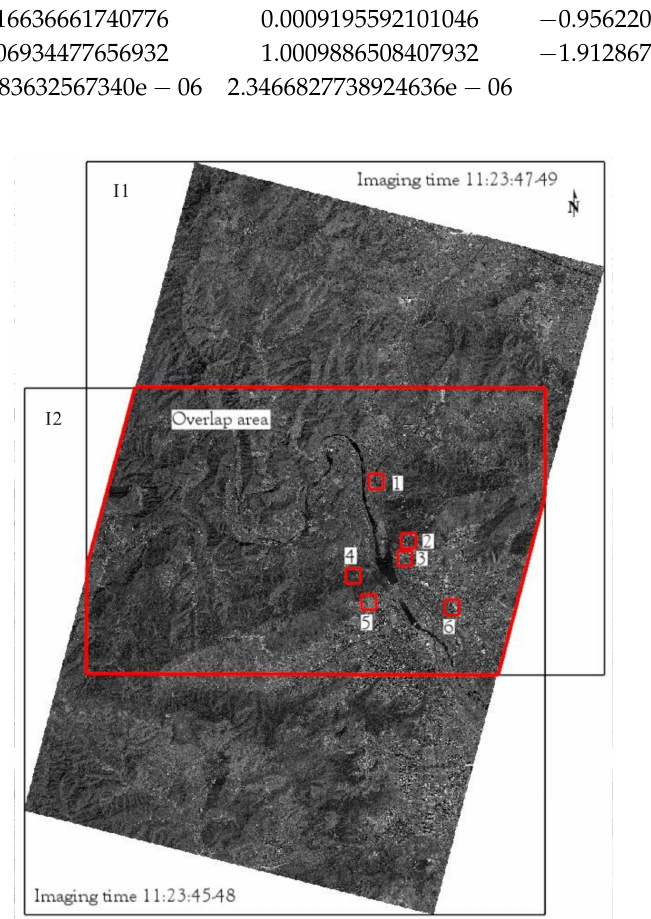
Figure 10. Test field in Mentougou district, Beijing, China. (1) expressway; (2) rural road; (3) bungalow; (4) tree; (5) bare soil; (6) high-rise